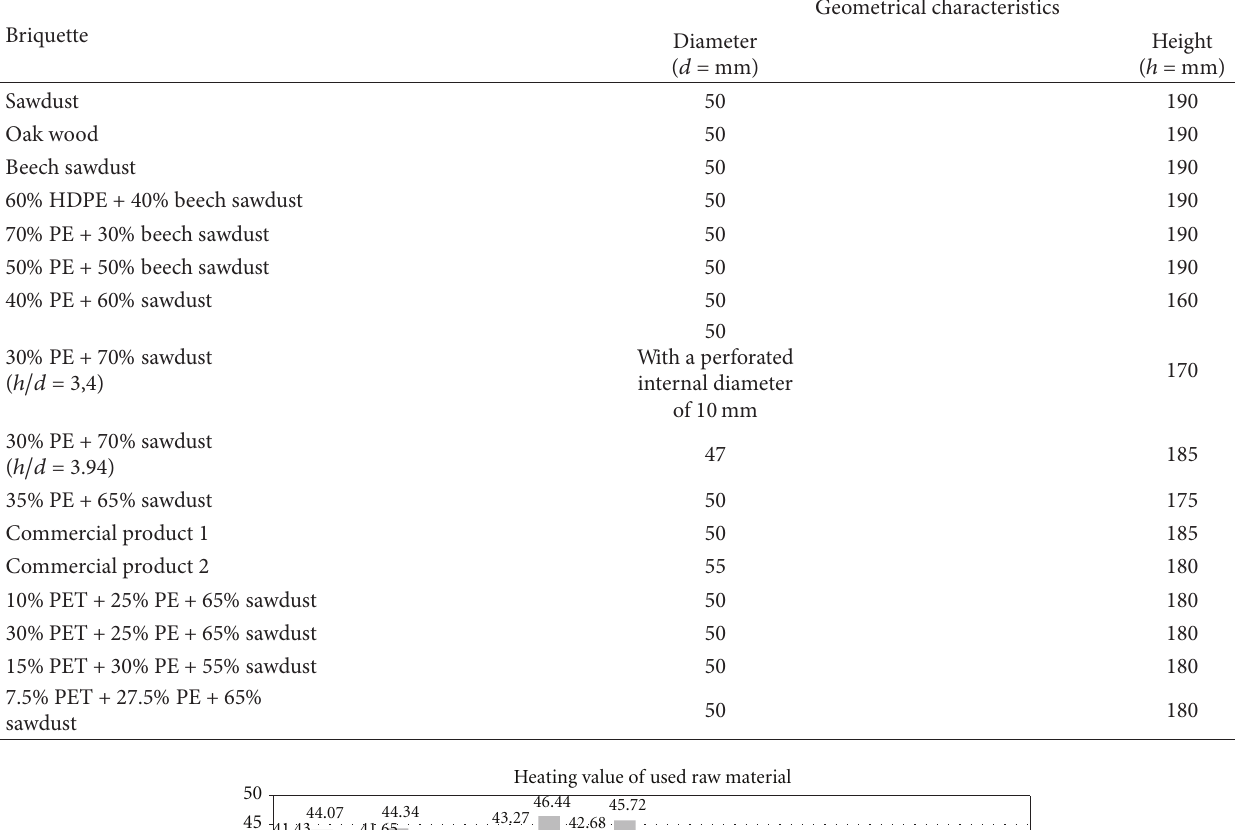
Geometrical characteristics